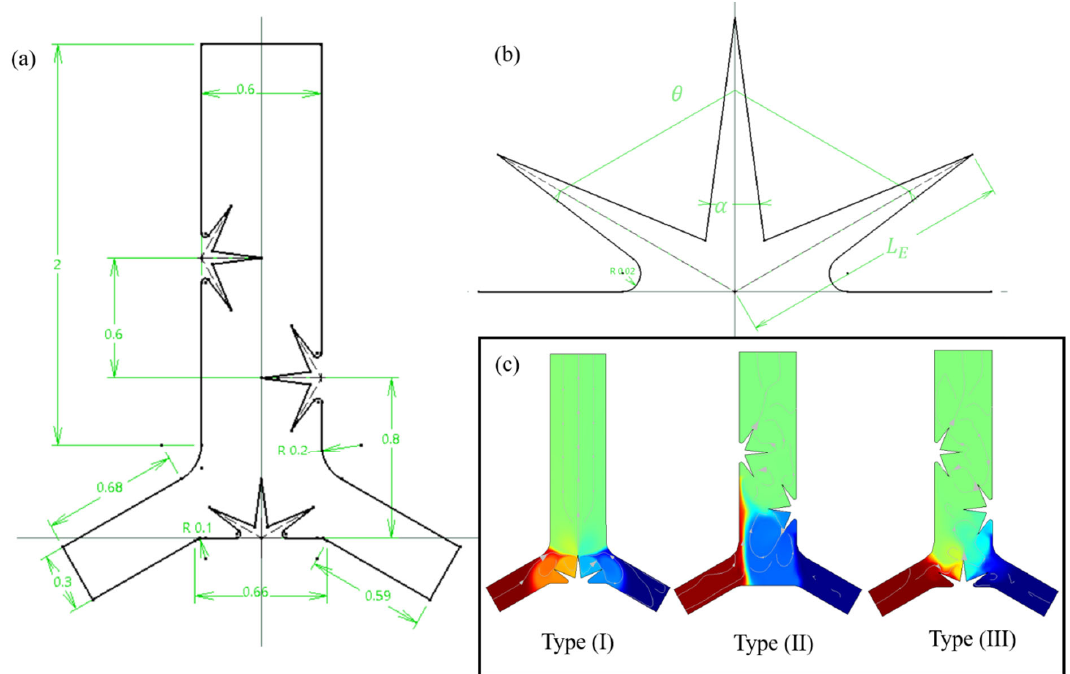
Figure 2. ( a ) A schematic illustration of an acoustic micromixer along with dimensions annotation. ( b ) The illustration of a 3-lobed leaf-shaped obstacle and the definition of parameters: length ( L E ), pitch angle ( θ ), and inside angle ( α ). ( c ) Three types of configurations for oscillatory obstacle placement inside the microchannel; Type (I) at the center of the junction; Type (II) on the side walls oppositely and asymmetrically; type (III) a combination of types (I) and (II).